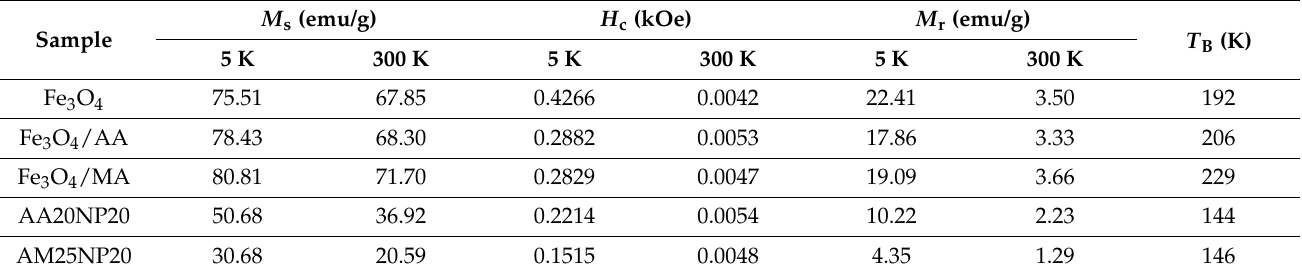
Table 4. Magnetic properties of the pure and modified Fe 3 O 4 and magnetic polymers.